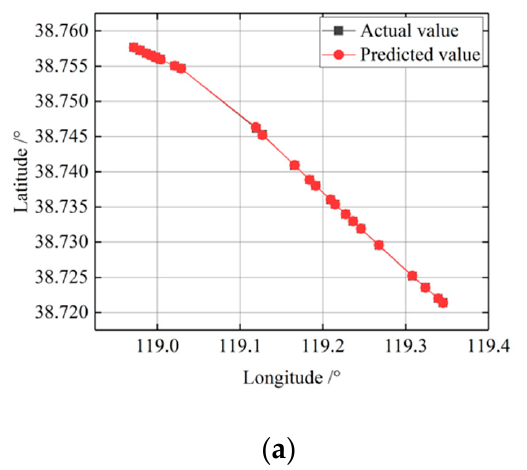
Table 6. Comparison of prediction error indicators between three trajectory prediction models.